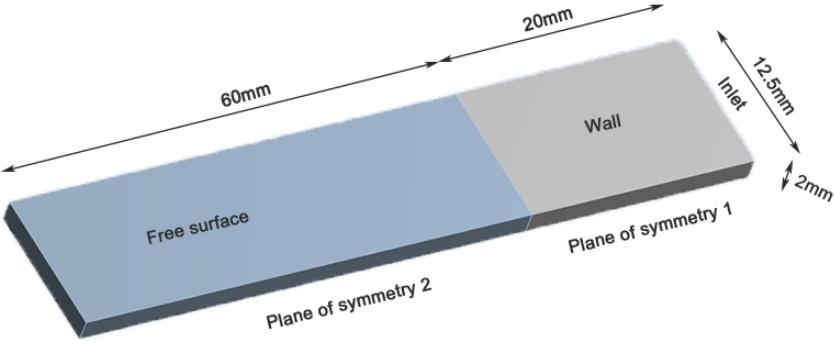
Figure 1. Schematic diagram of the 3D flow domain in and out of the slit die.